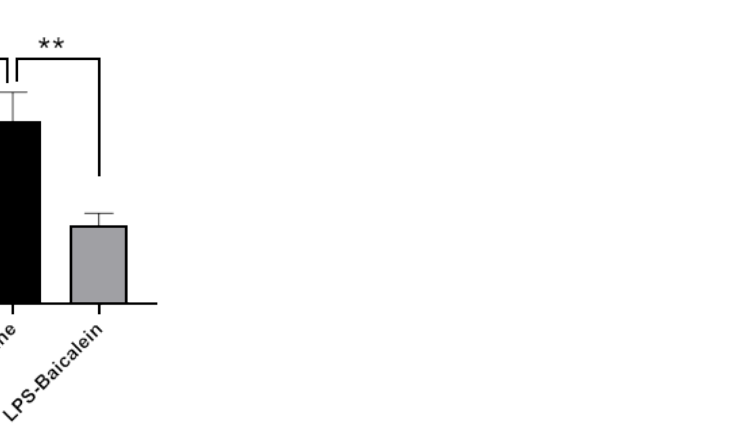
Figure 5. Effect of baicalein on the H 2 O 2 - scavenging activity in vivo. The H 2 O 2 - scavenging activity decreased after administration of LPS (1 mg/kg, i.p.), as assessed using a luminol-amplified chemiluminescence test. Treatment with baicalein (3 mg/kg, i.p.) 1 h after LPS administration markedly increased the H 2 O 2 -scavenging activity. Data are presented as means ± SEM. ( n = 6) ** p < 0.01.